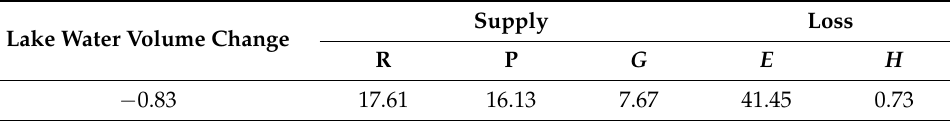
Table 8. Water quantity change and the proportion of each component in Lake Qinghai. (Unit: 10 8 m 3